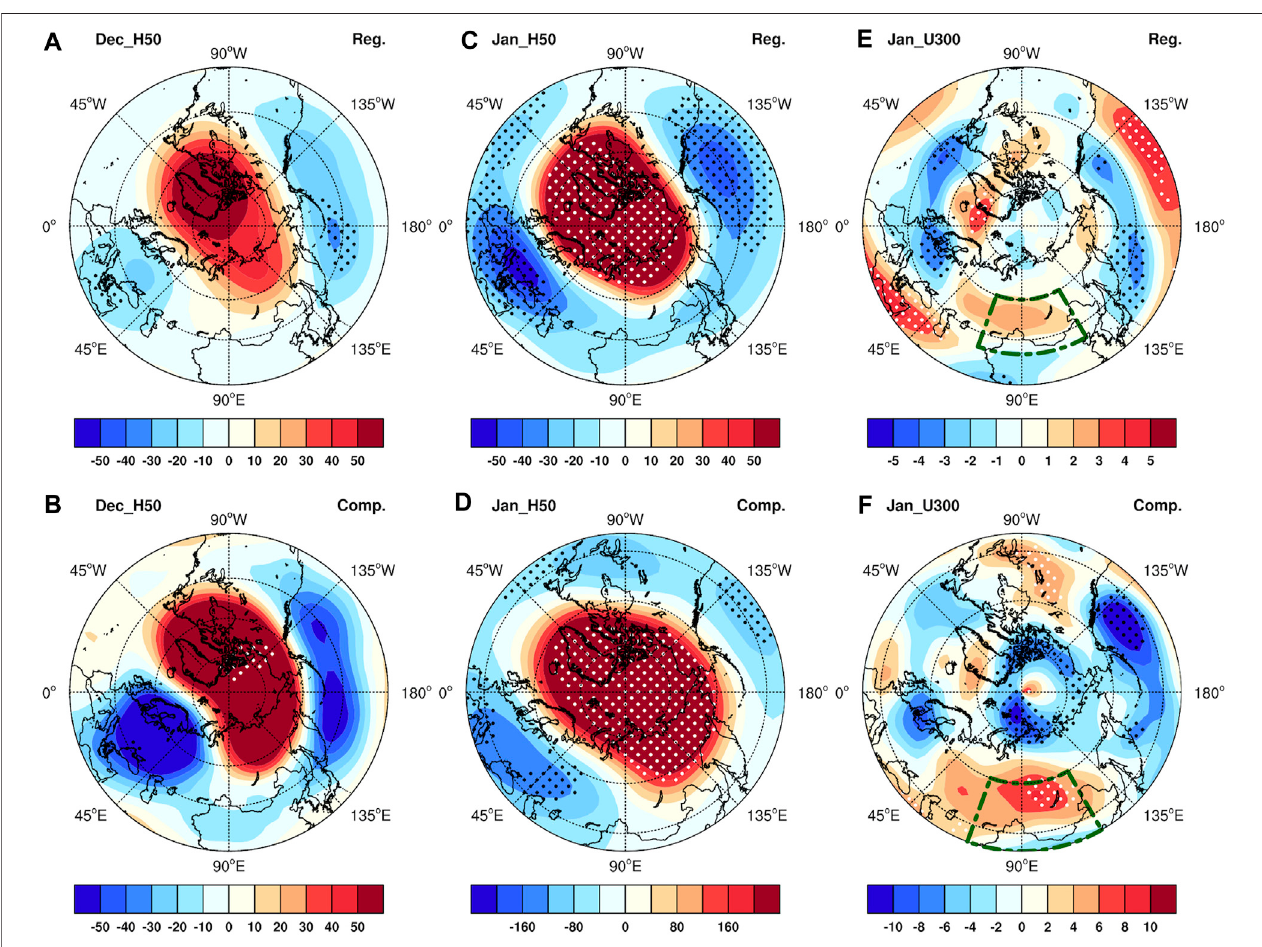
FIGURE 6| (A, C, E) Regressions ofvariables on the November SSDI and (B,D, F) results of composite differencesbetween SSD H – SHI + − and SSD L – SHI − + during 2000/01 – 2018/19: (A, B) December geopotential height at 50 hPa (units: gpm); (C, D) January geopotential height at 50 hPa (units: gpm); (E, F) January zonal wind at 300 hPa (units: gpm). Dotted regions are statistically signi fi cant at the 90% con fi dence level, based on the t -test. The green dotted rectangle represents the key area of the SH (40 ° – 60 ° N, 70 ° – 120 ° E) in (E, F) .